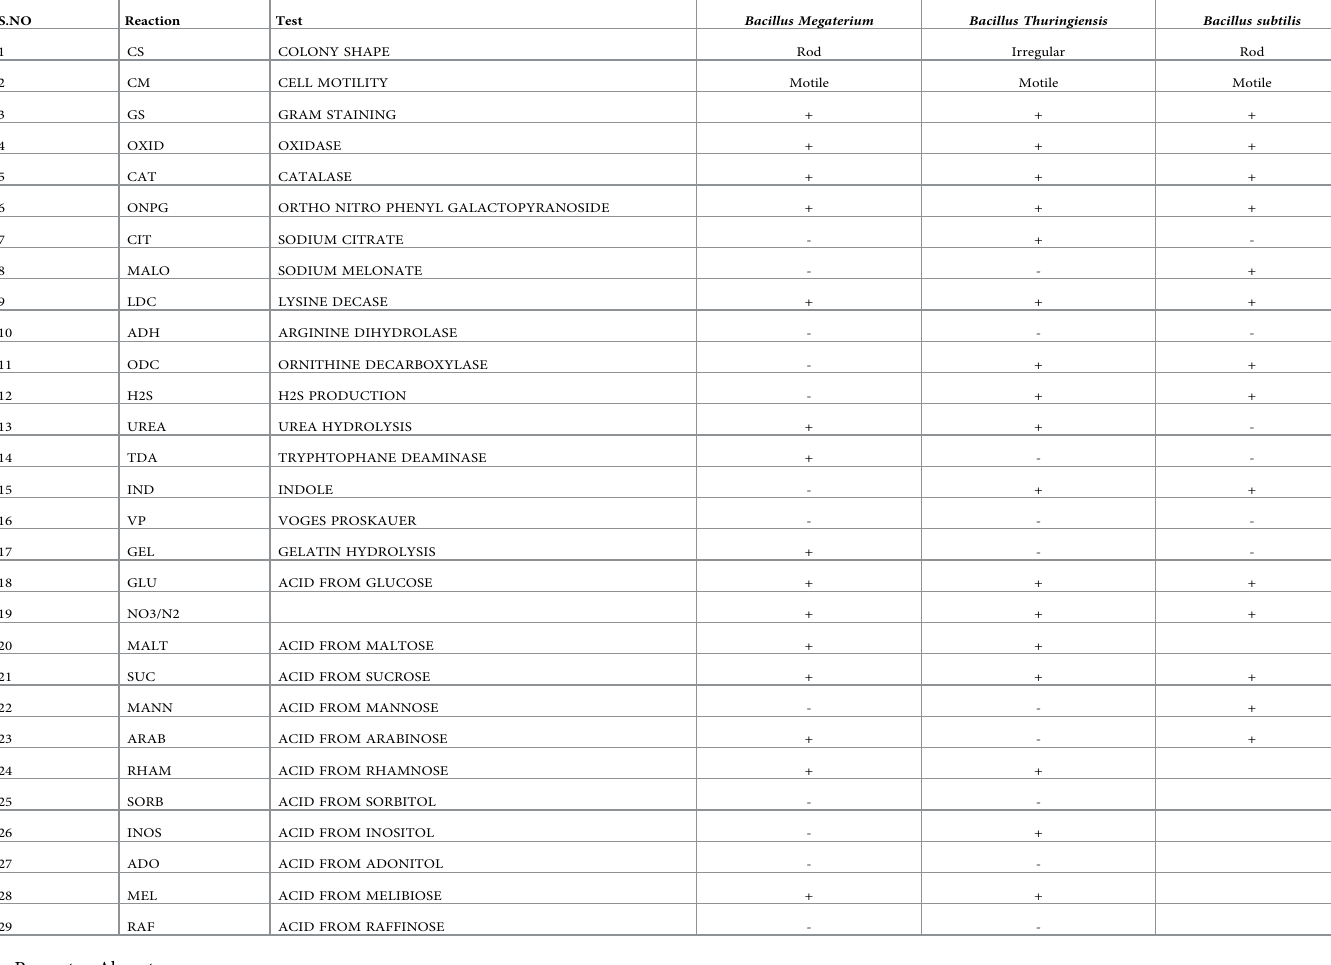
Table 1. Morphological, physiological and biochemical characteristics of isolated bacterial